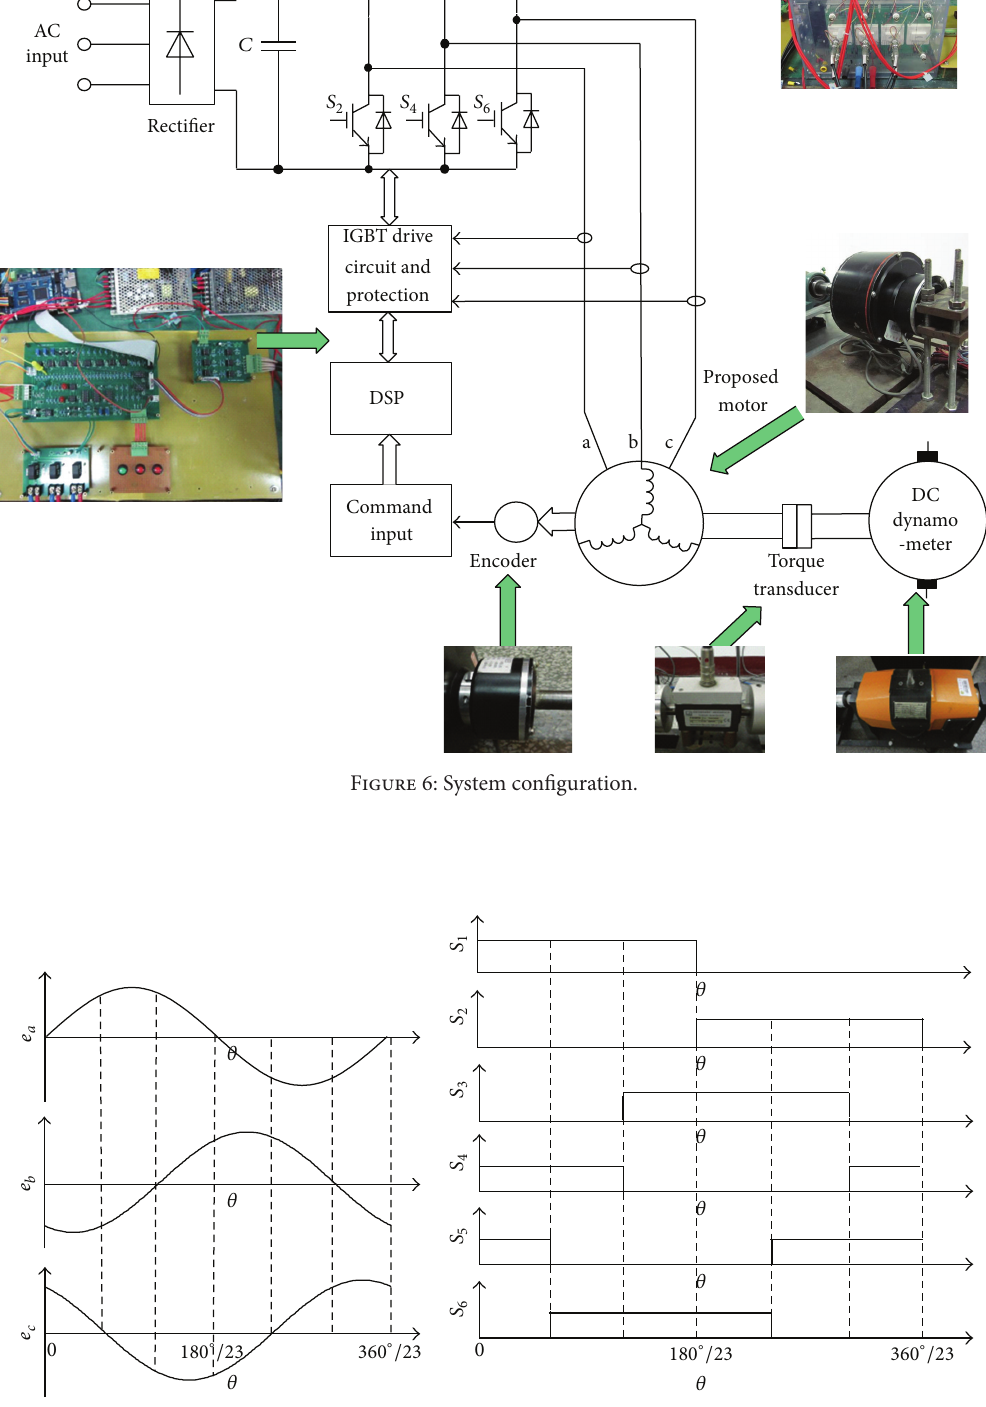
Figure 7: Control